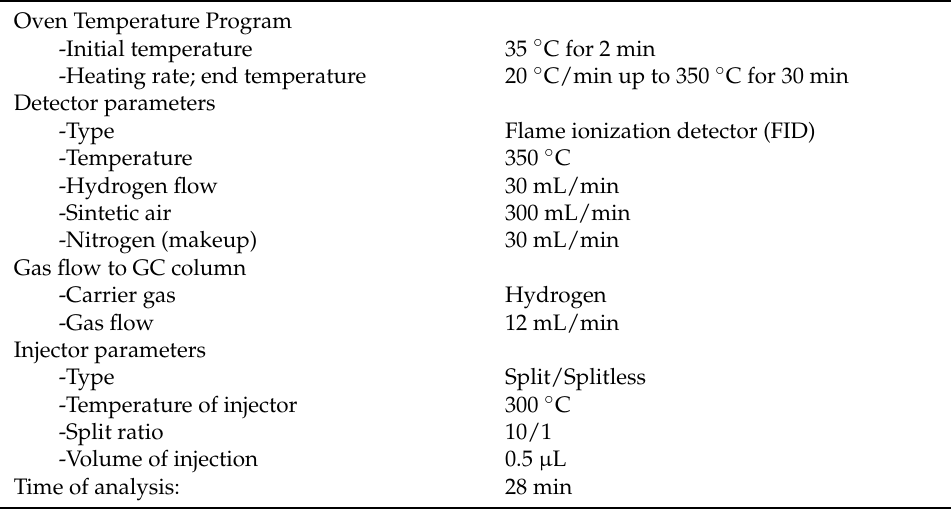
Table 4. Parameters used for gas chromatography analysis.